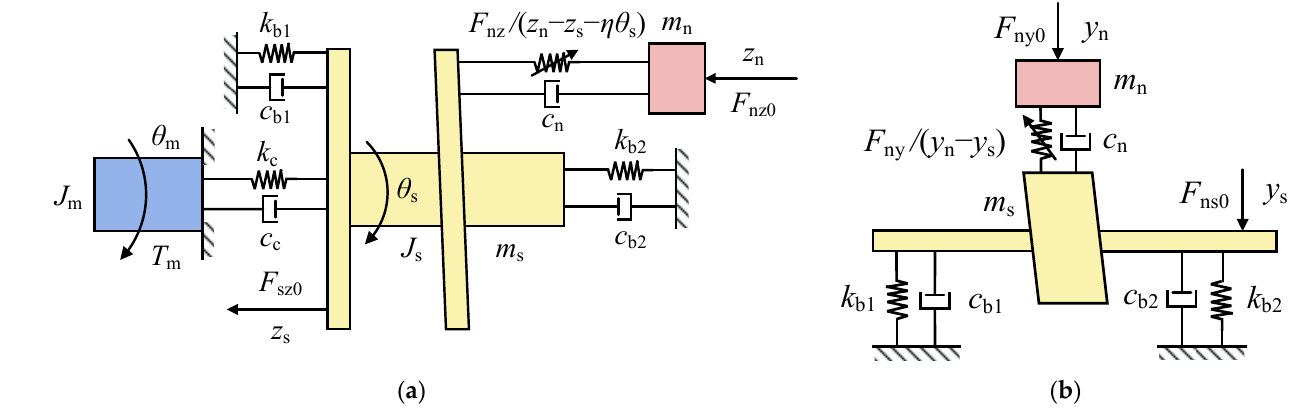
Figure 3. Dynamic model of an EMA mechanical transmission. ( a ) Axial model; ( b ) radial model.